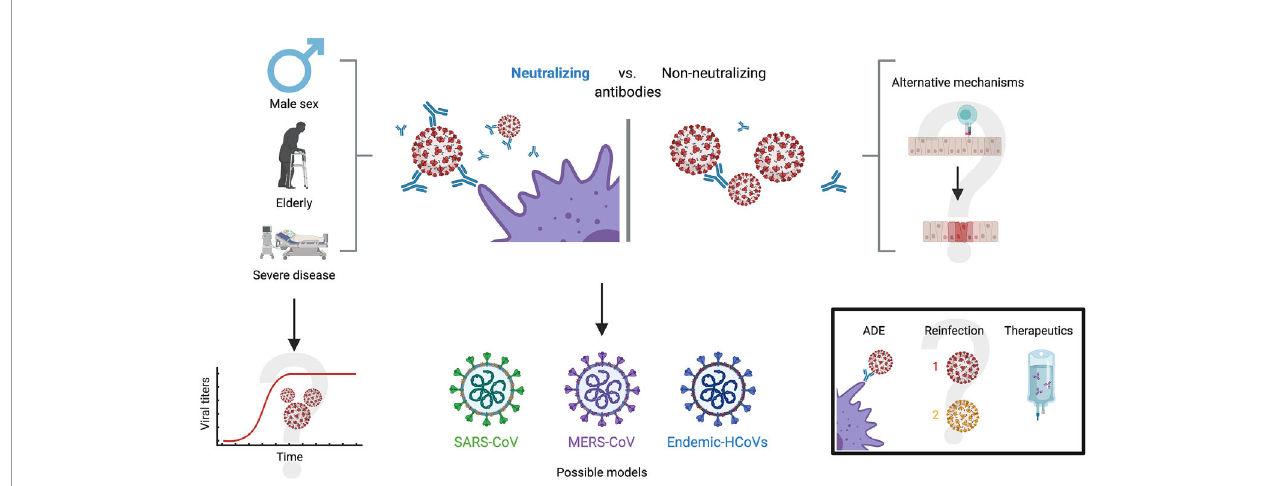
FIGURE 5 | Antibody neutralization in COVID-19. Three characteristics appear to hold a close relationship with high antibody neutralization capacity: male sex, old age and severe disease. A possible explanation is viral persistence in patients with these characteristics, but this is yet to be con fi rmed. On the other side of the spectrum, alternate mechanisms have been proposed for patients that do not develop robust neutralizing antibodies, such as high cytotoxic activity and a robust innate immune response, although these remain undetermined. For investigating neutralizing dynamics against SARS-CoV-2, other models with similar coronaviruses have been explored, such as SARS-CoV, MERS-CoV and endemic CoVs. Further investigation on neutralizing capacity will present de fi nitive solutions to the enigmas of antibody-dependent enhancement, likelihood of reinfection and the effectiveness of treatments such as convalescent